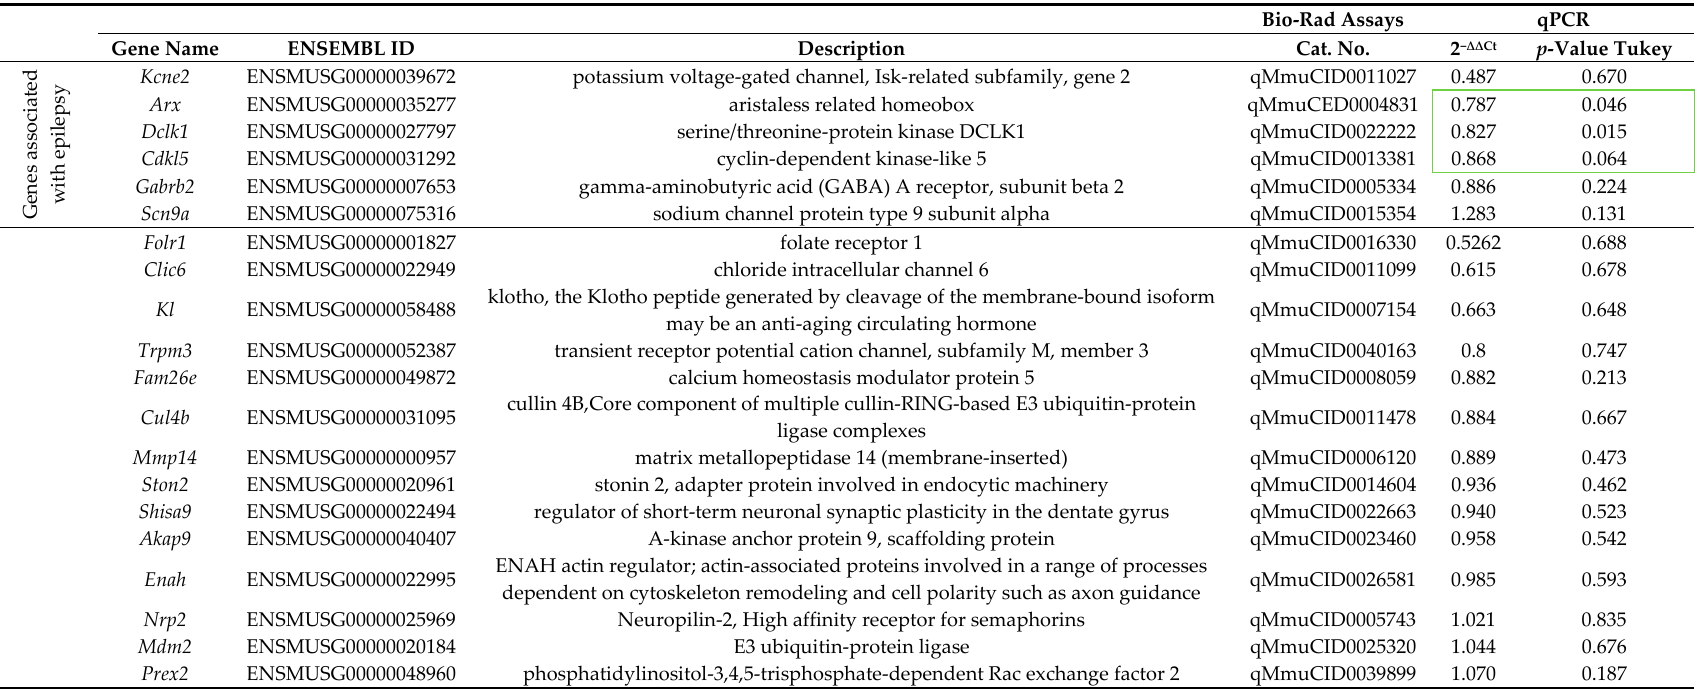
Table 1. A list of selected genes that were chosen for validation using customized arrays. Arx, Dclk1 , Cdkl5 and were subsequently taken to ddPCR analysis (framed in green).